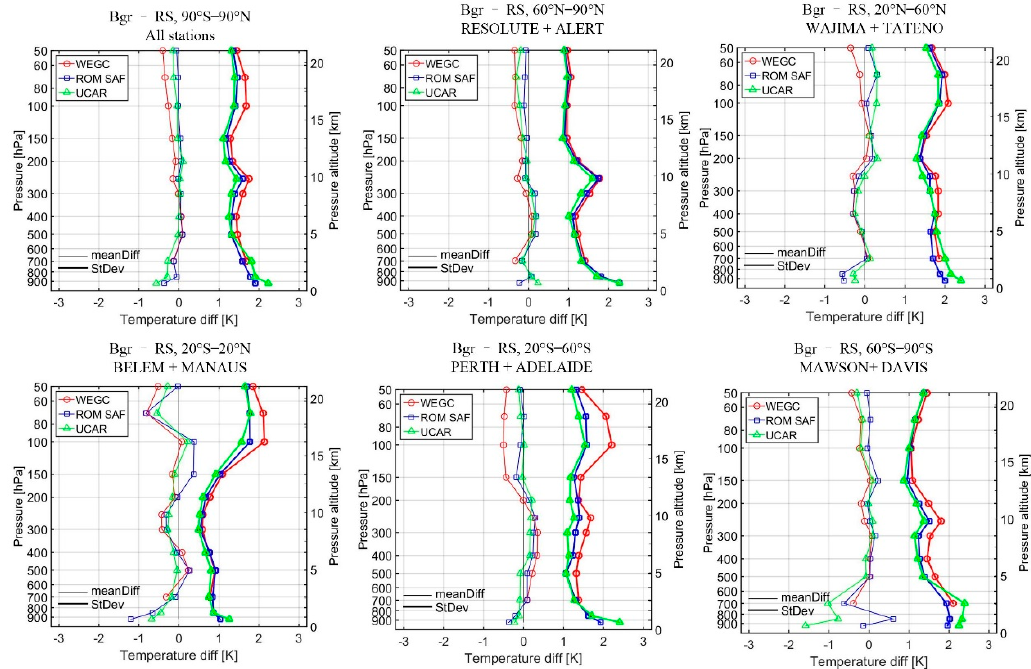
Figure 4. Temperature mean differences (meanDiff) and corresponding standard deviations (StDev) between background profiles and RS of WEGC, ROM SAF and UCAR over the period of 2007 to 2010 at the six latitudinal bands the same as Figures 2 and 3.